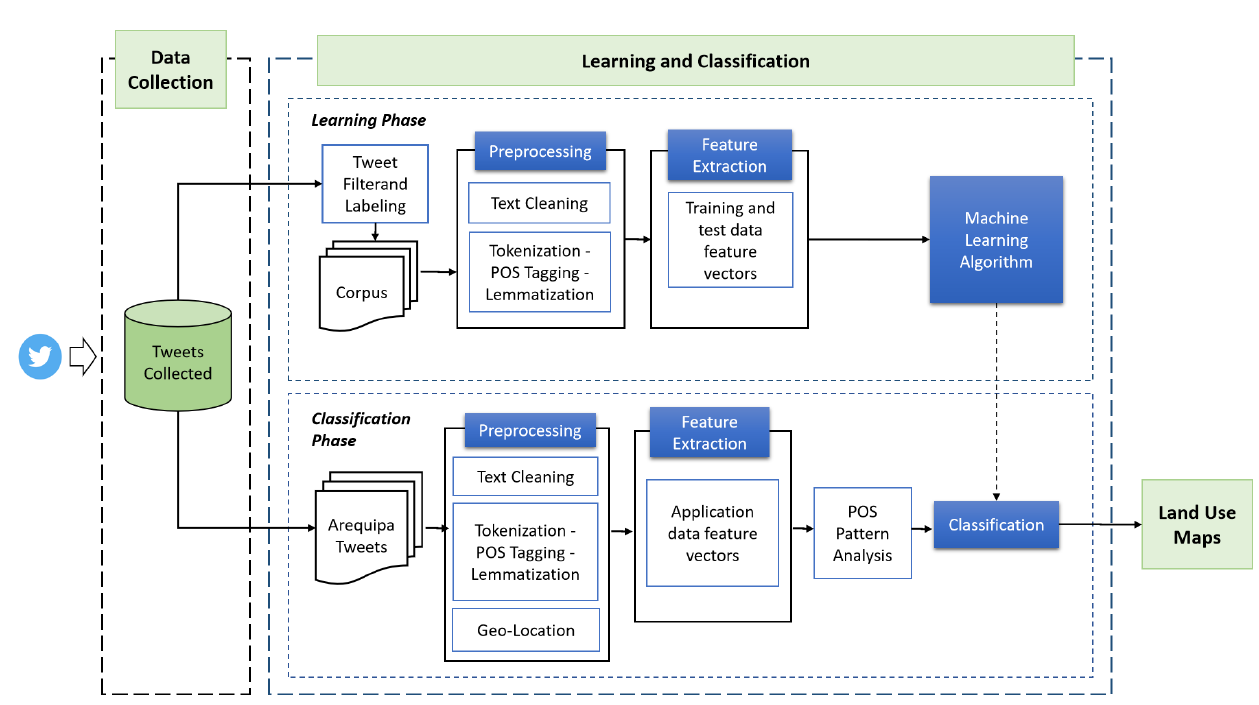
Figure 2. Outline of the proposed